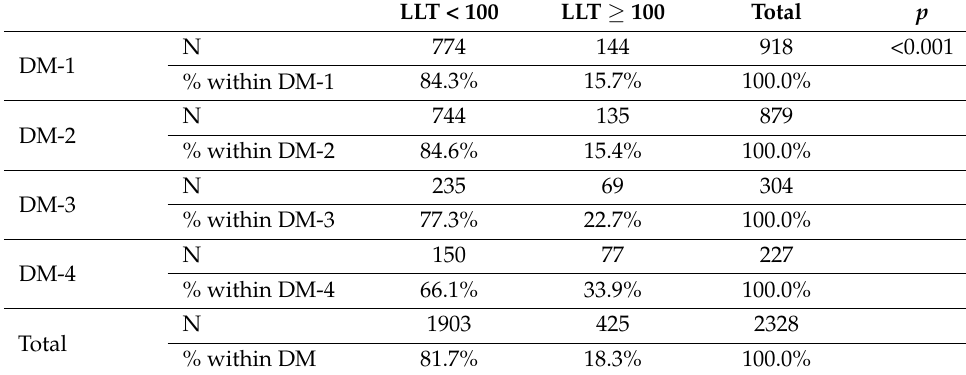
Table 4. Distribution of LLT ≥ 100 nm among the dermatochalasis